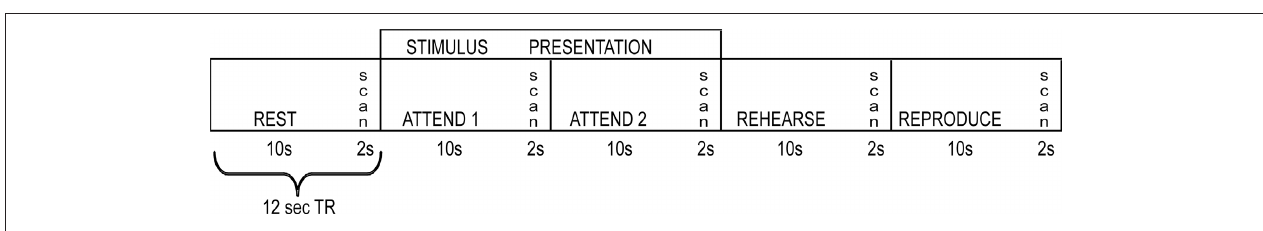
FIguRe 4 | A schematic representation of the fMRI scanning session for both auditory and visual conditions. A sparse sampling approach was adopted by clustering image acquisition into a 2 s interval preceded by 10 s of scanner silence. This approach gave an effective TR of 12